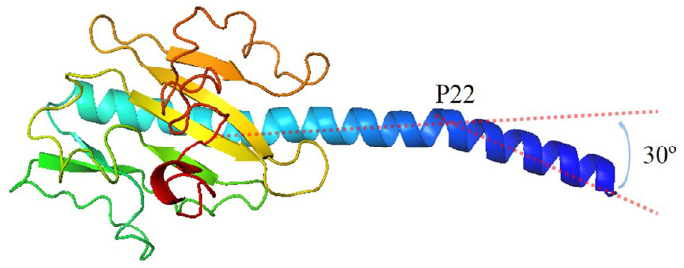
Figure 2. Structure of monomer in G.uraniireducens pilus. The bending of N-terminal helix is 30°. The position of curvature is the 22th amino acid.